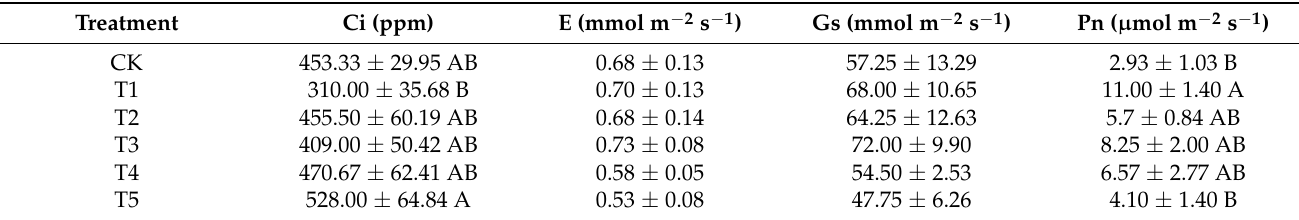
Table 2. Differences of Ci (internal CO 2 concentration), E (transportation rate), Gs (stomatal conductance) and Pn (pho- tosynthesis rate) of pecan seedlings under varying NH 4+ :NO 3 − ratios. Uppercase letters indicate differences between NH 4+ :NO 3 − ratio treatments, at p < 0.05.